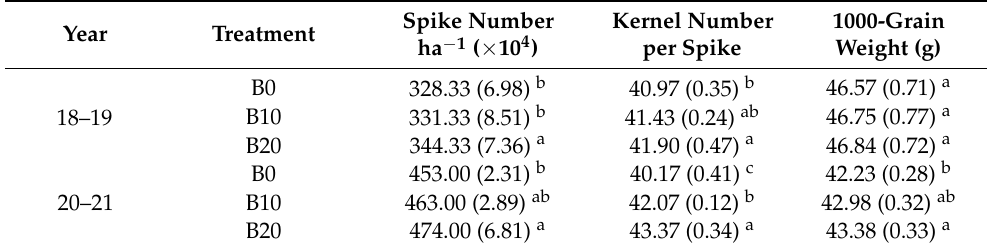
Table 3. Wheat yield components under different amounts of added biochar in 2018–2019 and